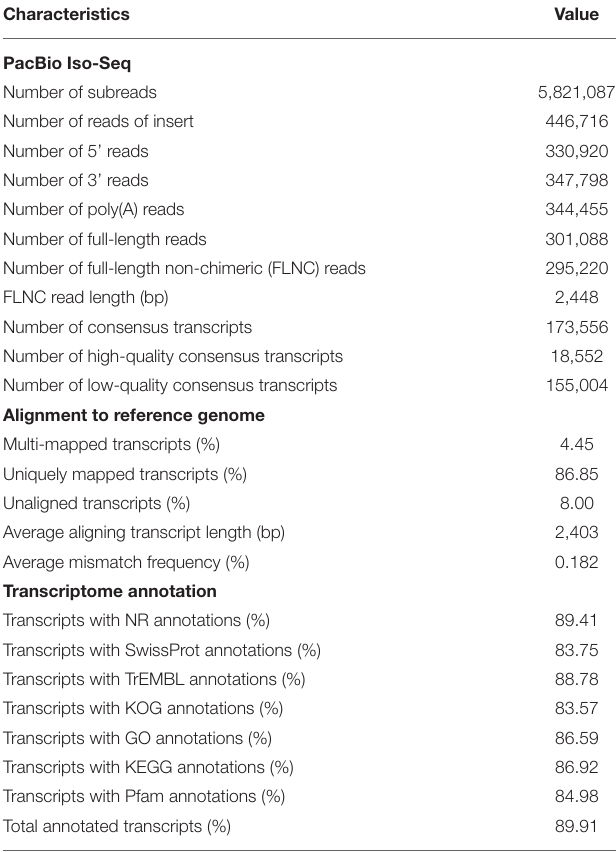
TABLE 1 | Statistics of G . lalandii Iso-Seq.